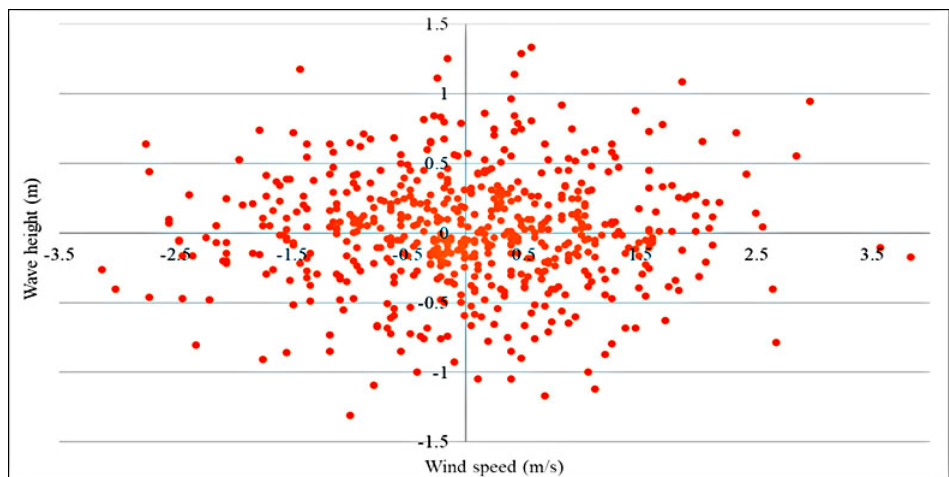
Figure 7. The relation between wave height and wind speed.